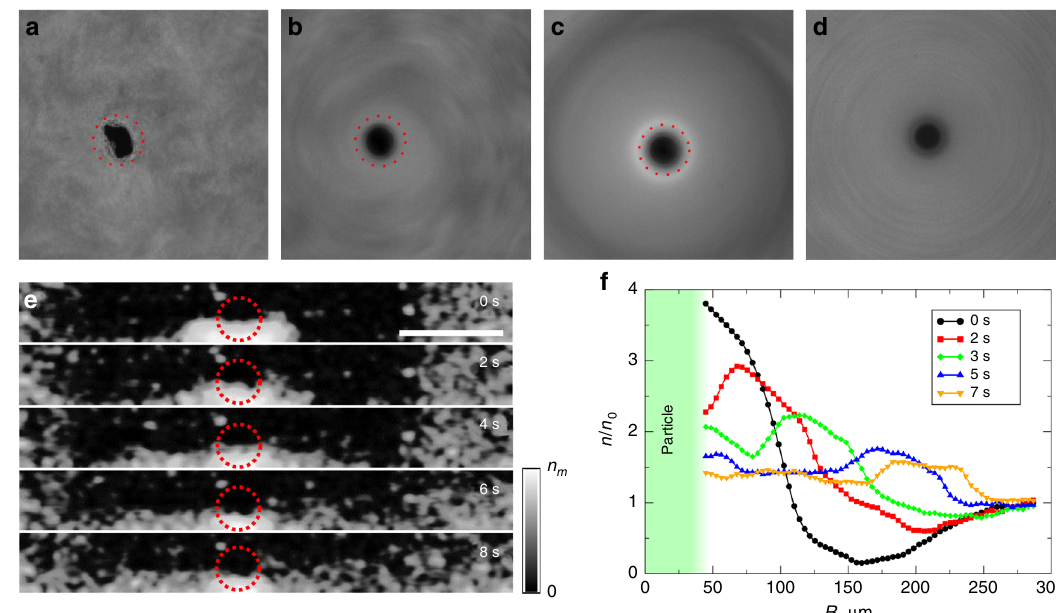
Fig. 2 Fluorescence and tomography analysis. a – d Images of fl uorescent bacteria in the vicinity of a rotating particle. White color corresponds to higher concentration of bacteria. Images are made from the bottom. The frequency of rotation is 160 Hz. a The initial distribution of live bacteria near the bottom of the fi lm before the onset of rotation. b Uniform distribution of bacteria immediately after the onset of rotation. c Stationary distribution of swimming bacteria around the rotating particle. Bacteria are concentrated in the close proximity of the particle. Red dashed circles illustrate the size of the particle. d Distribution of dead (non-motile) bacteria remains uniform. Scale bar is 50 μ m. e The OCT images showing bacterial distribution around the particle in a vertical cross-section at different moments of time after cessation of rotation. The OCT probe is scanning from the bottom. Bright white color corresponds to higher bacterial concentration, n m = 10 11 cm − 3 . The bottom part of the spinning particle (dashed red circle) and concentrated bacteria are visible as a bright spot near the center of the fi rst image. The droplet of concentrated bacteria is expanding along the bottom surface of the fi lm in four consecutive images. Scale bar is 200 μ m. f Averaged radial distributions of bacteria around the particle at different moments of time after cessation of rotation. n 0 is concentration of bacteria far from the angular sectors with respect to the center of rotation, see Fig. 3a – c. The local curvature χ and interface normal velocity V were calculated for each frame in the experiment Fig. 3d and simulation Fig. 3e. Despite the experimental noise, one can see